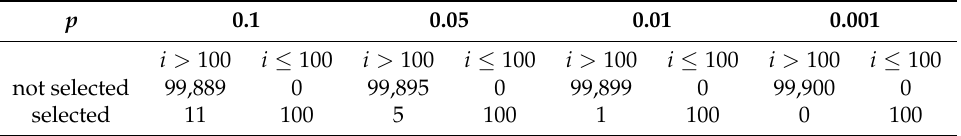
Table 3. Confusion matrices when categorical regression is applied to synthetic data. p is the threshold p -value. Features are selected when adjusted p -values less than the threshold p -values are associated with them. Averaged over 100 independent trials.